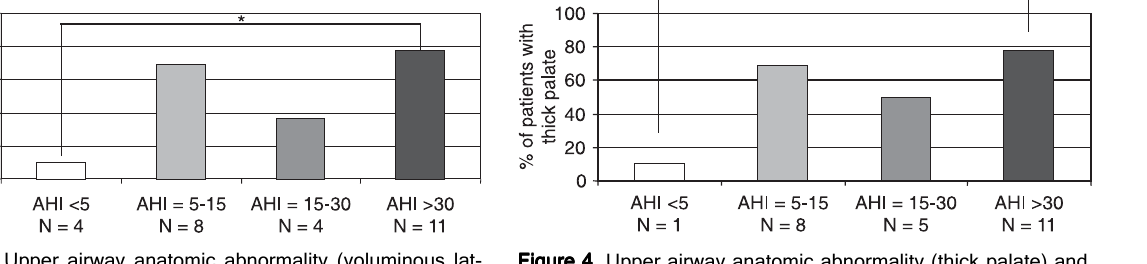
Figure 4. Upper airway anatomic abnormality (thick palate) and severity of obstructive sleep apnea syndrome in class III obese patients. AHI = apnea-hypopnea index. *P = 0.04 (chi-square